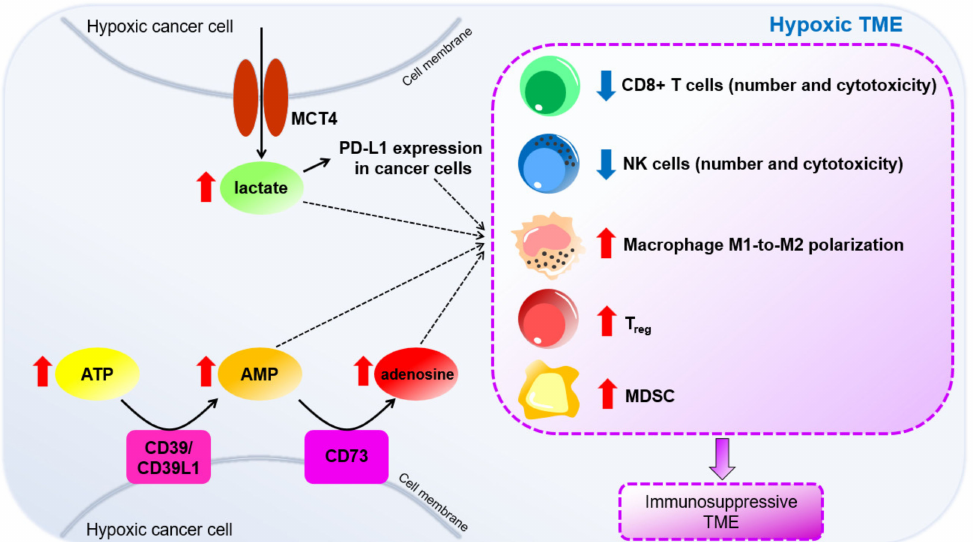
Figure 4. HIF-induced metabolic reprogramming under hypoxia creates an immunosuppressive TME. HIF-mediated induction of lactate metabolism and adenosinergic metabolism leads to the accumulation of oncometabolites, including lactate, adenosine monophosphate (AMP) and adenosine at TME that inhibits anti-tumoral immune cells and promotes expansion of protumoral immune cells, resulting in an immunosuppressive TME that aids immune evasion of tumor